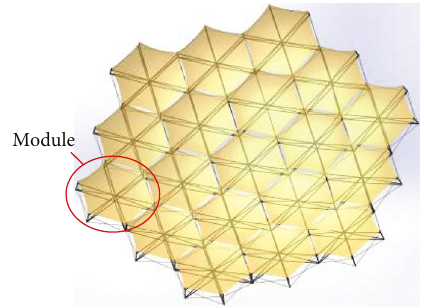
Figure 2: Structure of a modular deployable